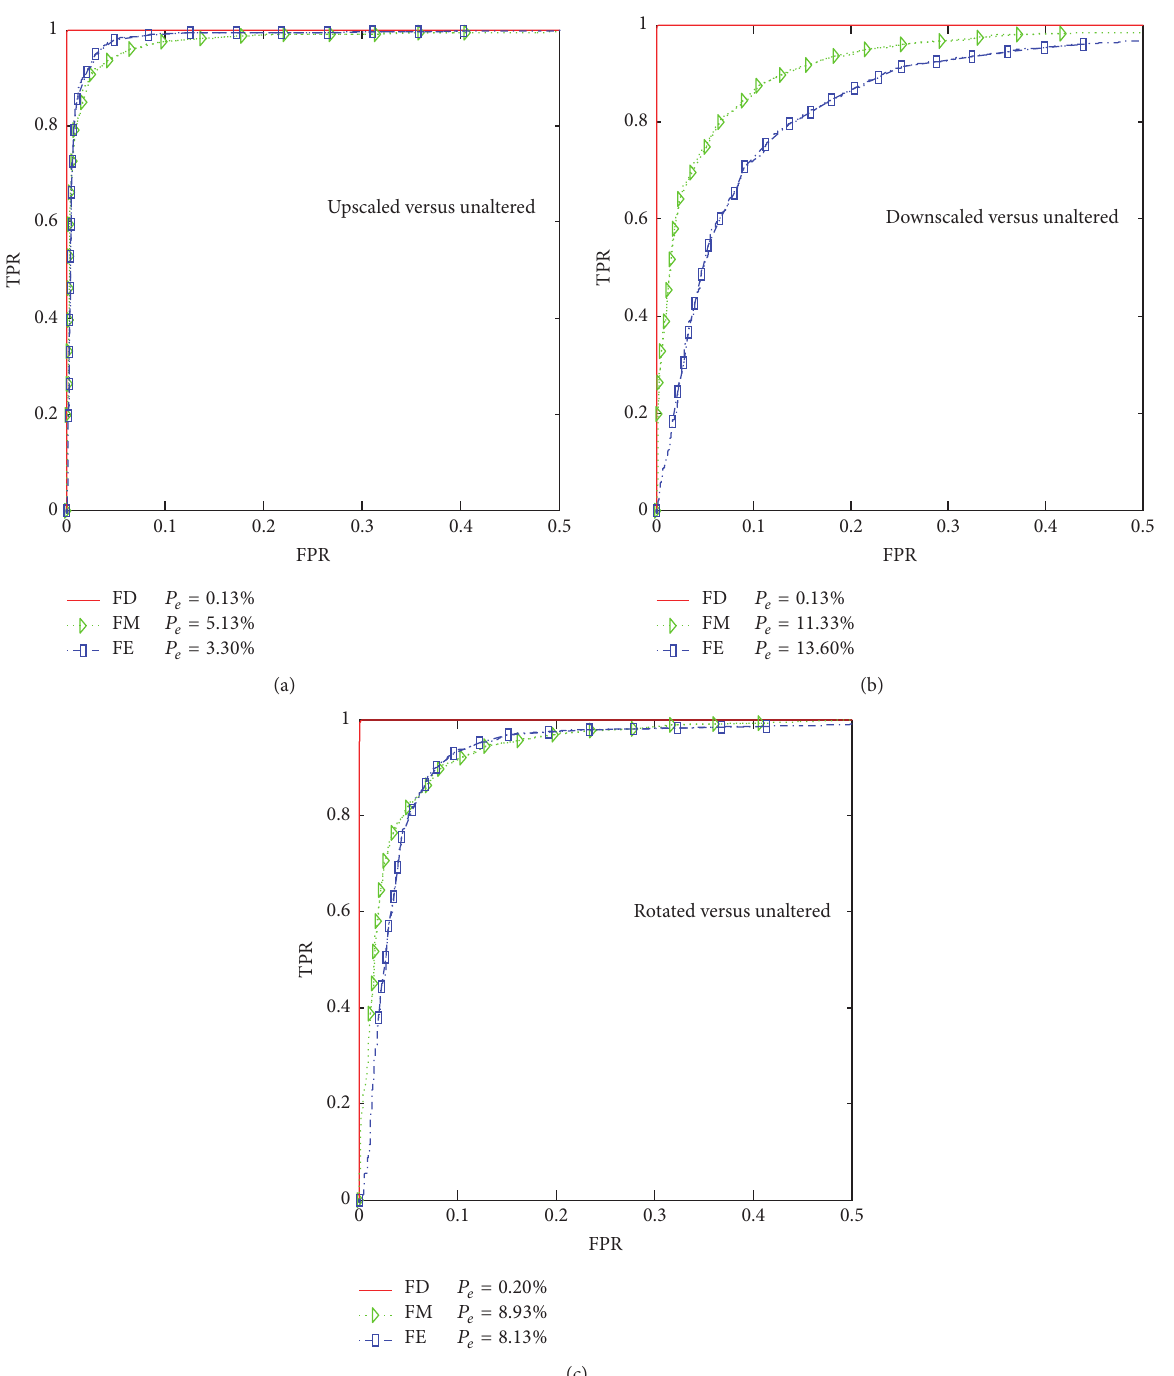
Figure 7: ROC curves showing detections of (a) forged upscaling, (b) forged downscaling, and (c) forged rotation under uncompressed